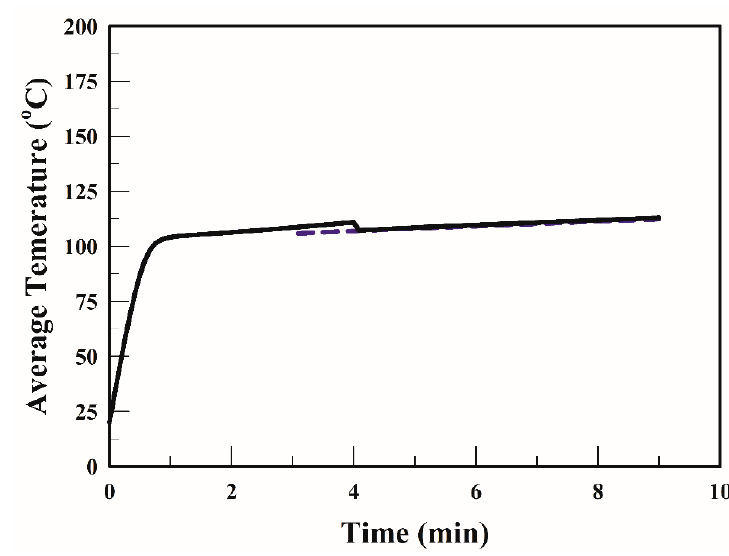
Figure 6. Profile of average temperature of the strip when fried with the temperature-step frying approach at 170 ◦ C for 3 min (dotted line) and for 4 min ◦ C (solid line).